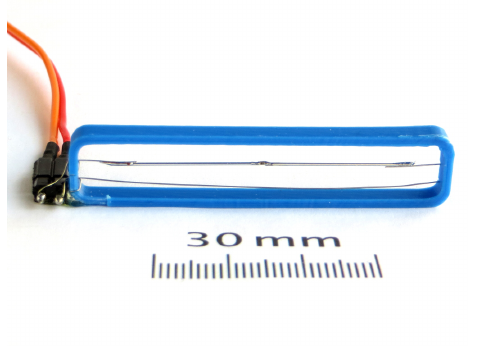
Figure 3. Sensor used for the measurement of the temperature of the air circulating inside COCAP. The sensing element (located in the centre of the blue 3-D-printed frame) is a miniature thermis- tor (1mm × 0.5mm × 0.5mm). Two 23mm long pieces of 0.5mm wire are soldered to both sides of the thermistor. They conduct heat, facilitating the measurement of a temperature that is averaged across the air